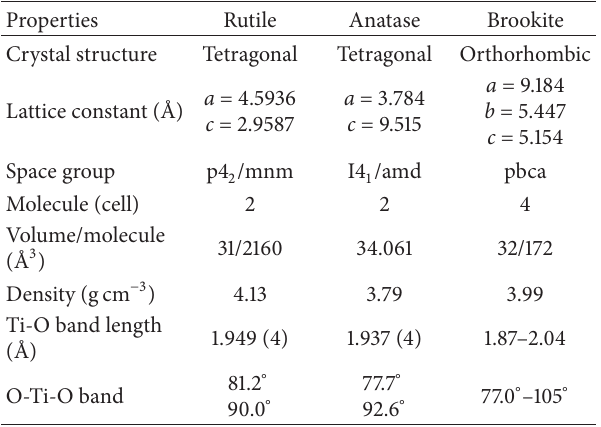
Table 1: The structural properties of TiO 2 crystals